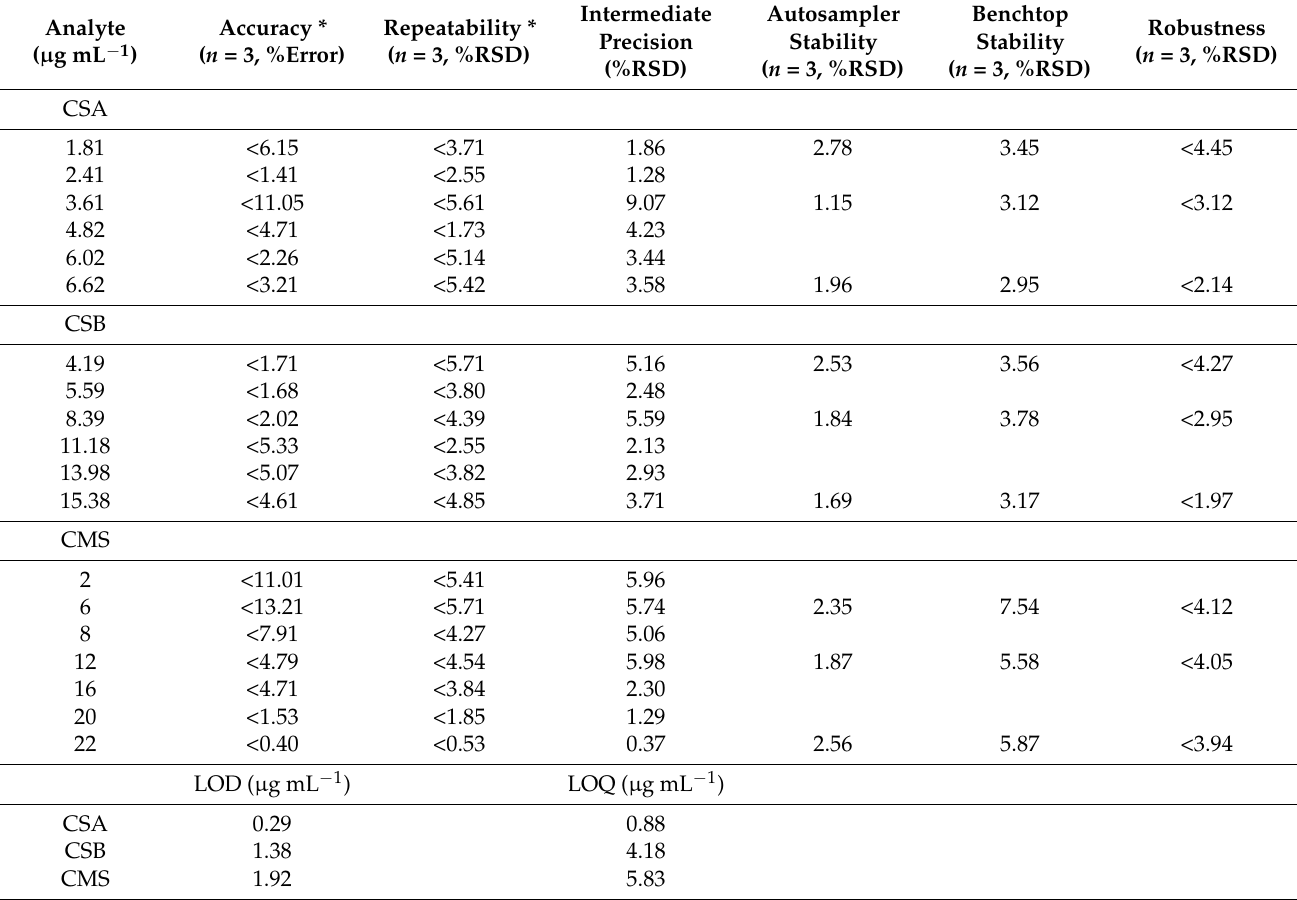
Table 2. Accuracy, repeatability, intermediate precision, stability (autosampler and benchtop), robustness, limit of detection (LOD), and limit of quantitation (LOQ) values calculated for CSA, CSB, and CMS. RSD, relative standard deviation.